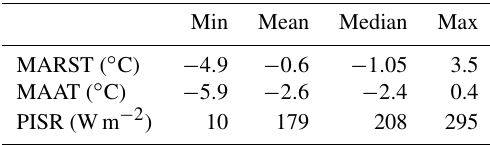
Figure 5. Pictures of the Ádjit crest ( a : March 2017, b : August 2018) showing variable bedrock settings more or less favourable to permafrost occurrence. 1. Vertical and compact bedrock. 2. Rugged bedrock surface with sparse snow deposits. 3. Mid-steep slope with substantial snow and debris accumulation. Yellow dots indicate log- ger locations. Table 4. Summary of the model variables.